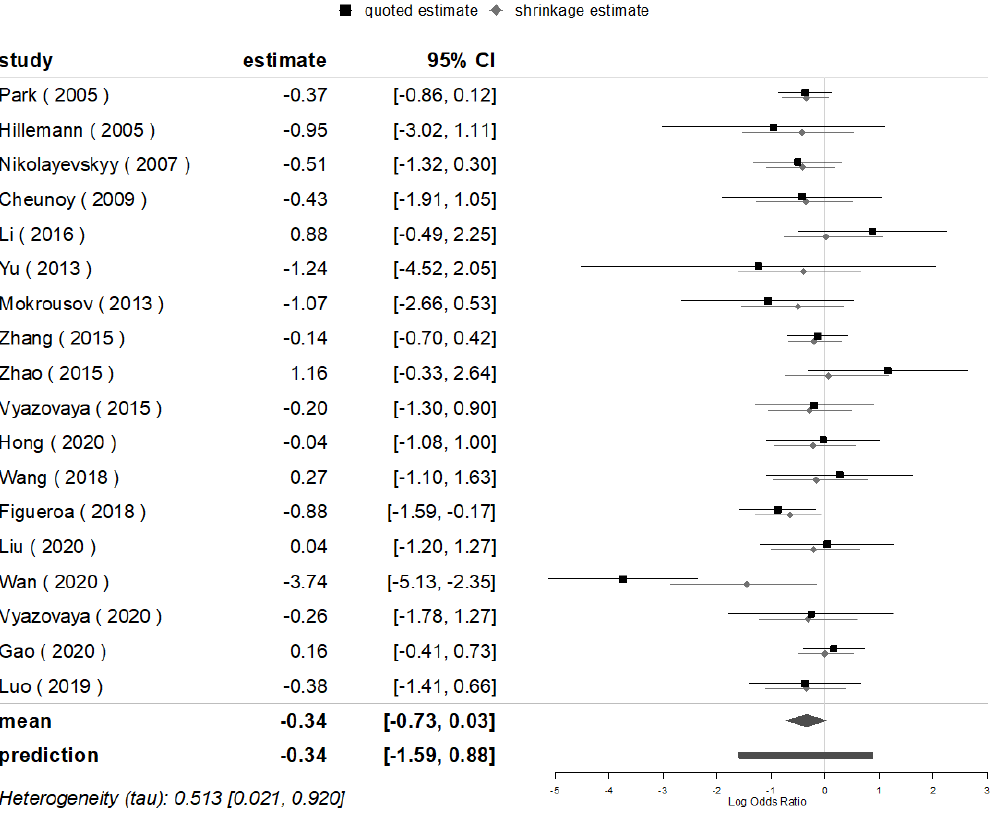
Genes 2022 , 13 , x FOR PEER REVIEW Figure 7. BMA for the mutations of inhA in Beijing and non-Beijing strains. Figure 7. BMA for the mutations of inhA in Beijing and non-Beijing strains.